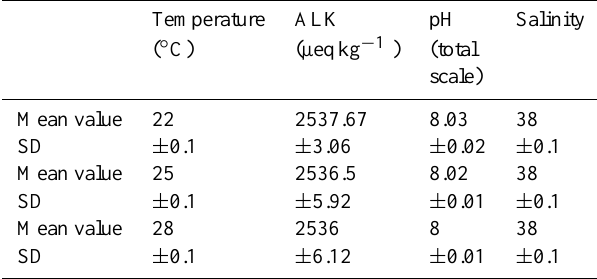
Table 2. Mean temperature ( ◦ C), ALK (µeqkg − 1 ), pH (total scale) and salinity of the culture media, measured during step 2 of the experiment. Measurements performed in culture tank submitted to HL (high light) and LL (low light) conditions were averaged and are presented under a single value per temperature